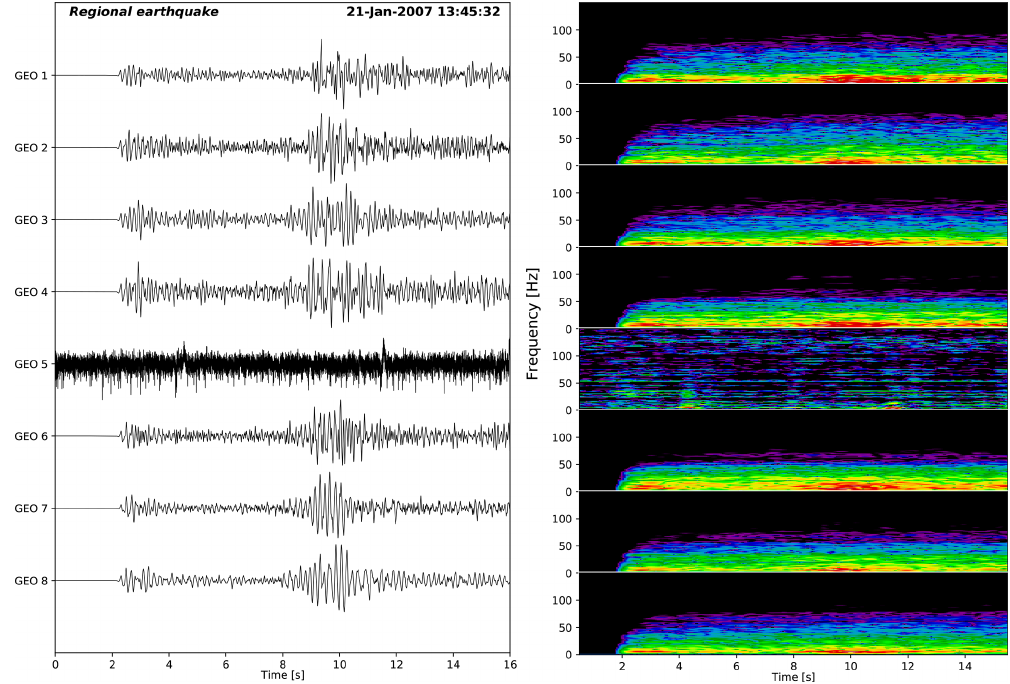
Figure B6. Example of a regional earthquake. P- and S-wave arrivals are clearly identifiable. Geophone 5 was not functional.